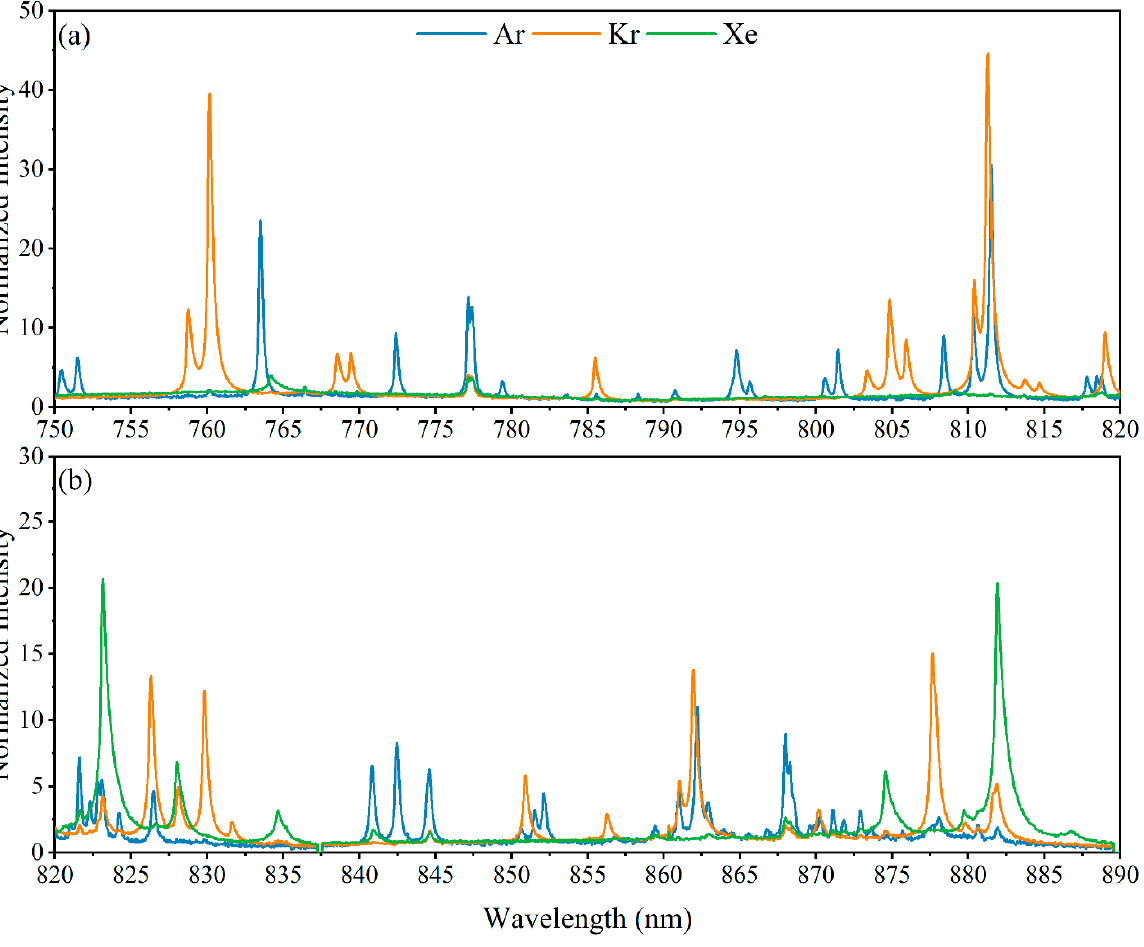
Figure 5. LIBS emissions of Ar, Kr, and Xe gasses overlaid to illustrate peak interferences in relevant wavelength ranges ( a ) 750–820 and ( b ) 820–890.